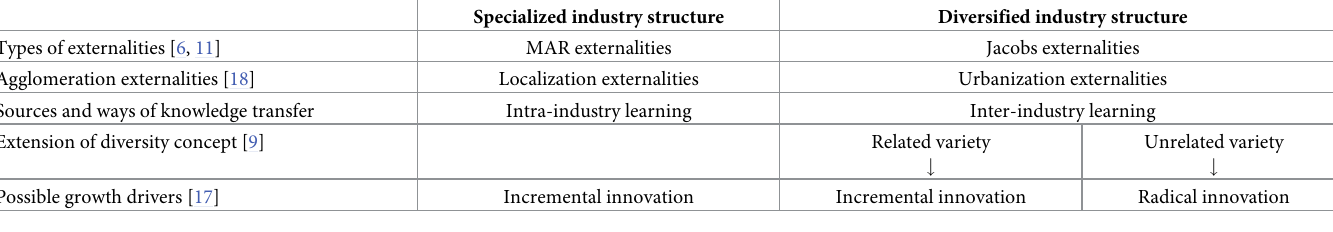
Table 1. Types of externalities associated with economics